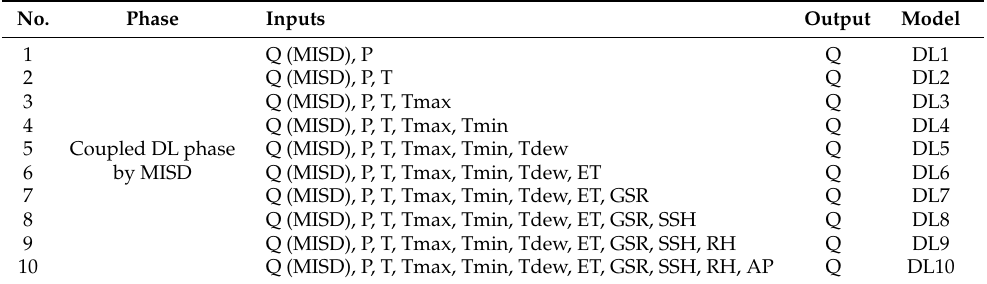
Table 4. Scenarios for adding extra meteorological variables to the MISD model by DL.